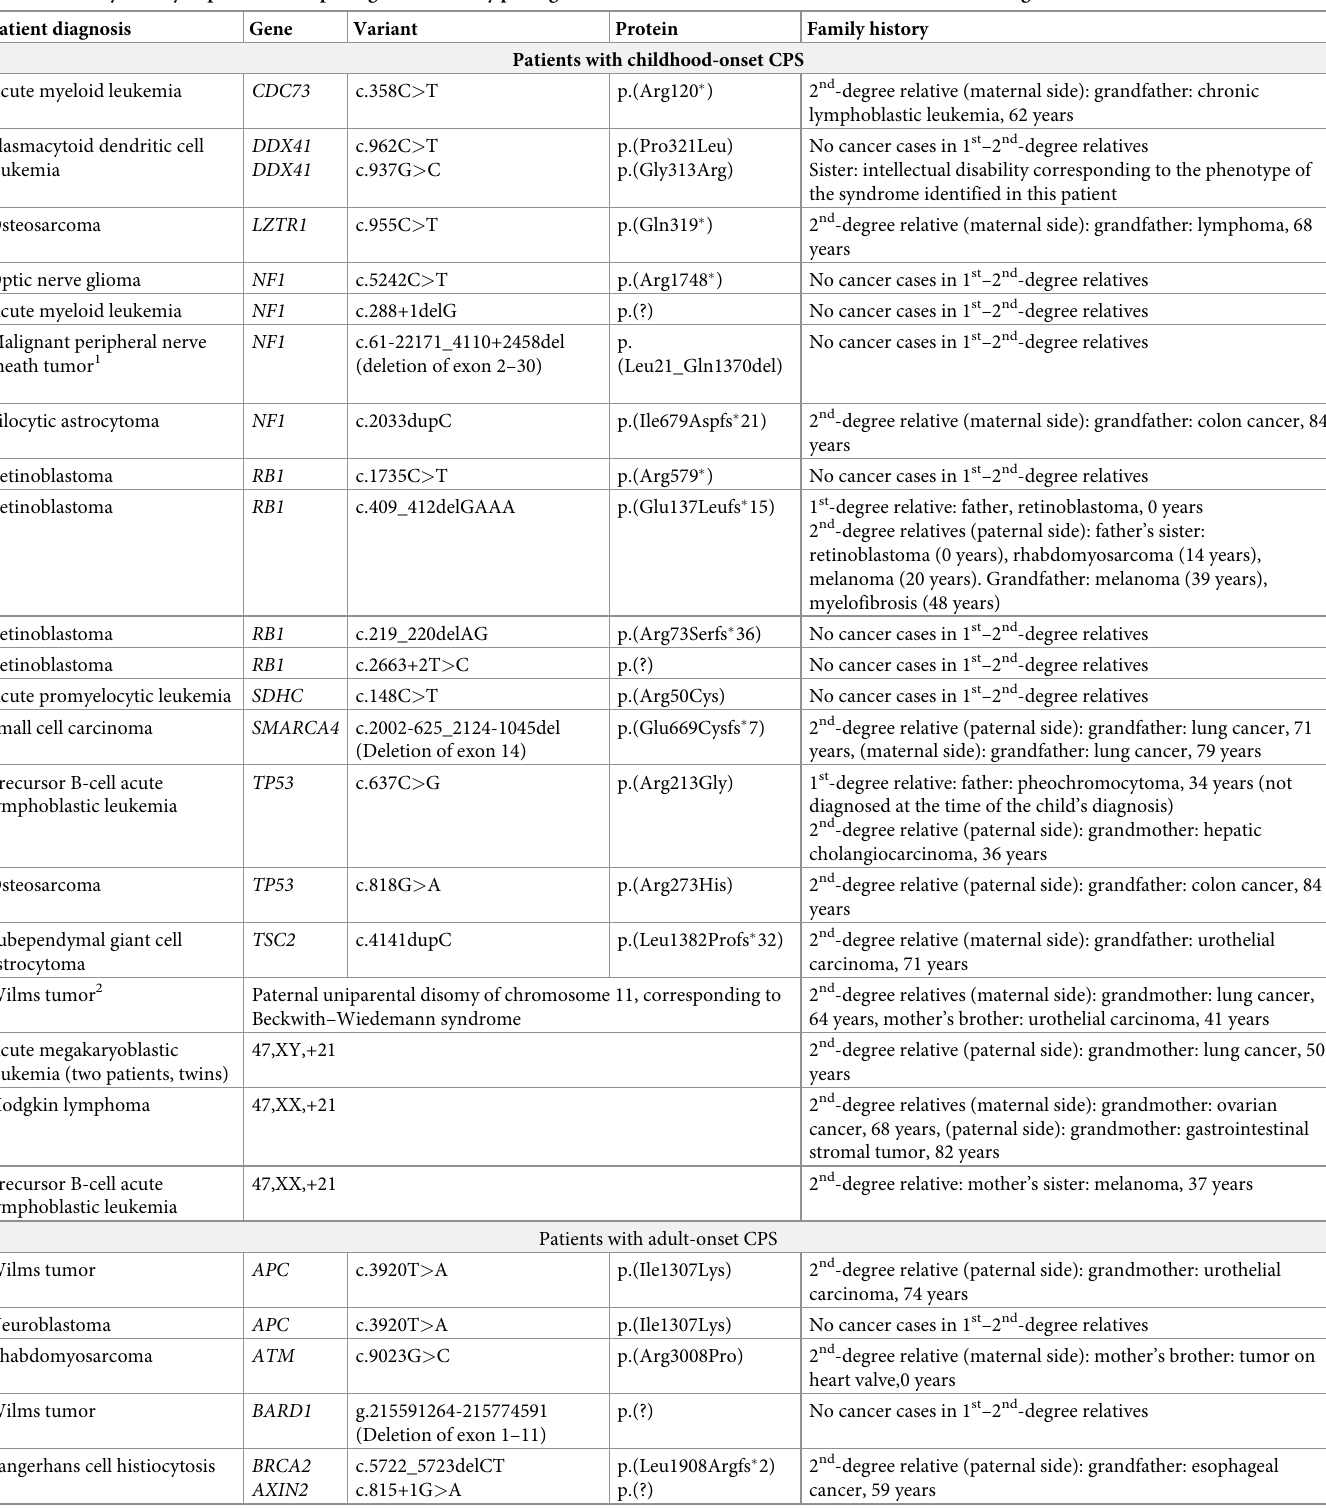
Table 5. Family history of patients with pathogenic and likely pathogenic variants in childhood-onset and adult-onset cancer